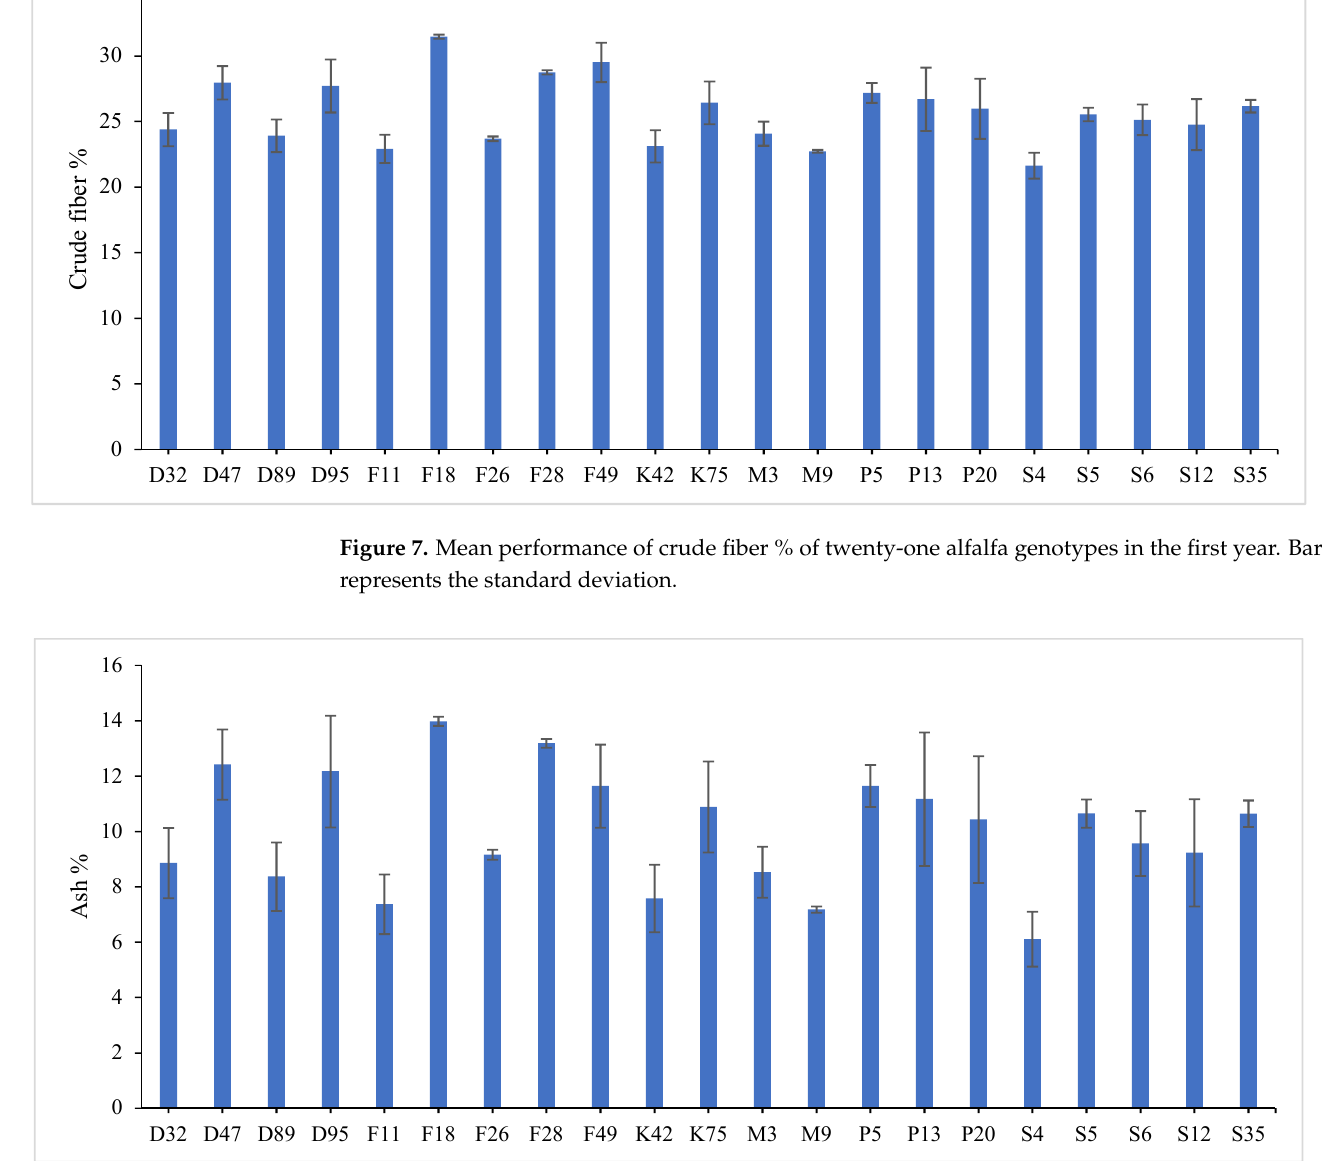
Figure 8. Mean performance of ash % of twenty-one alfalfa genotypes in the first year. Bar represents the standard deviation.